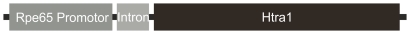
Scheme of the transgenic construct Rpe65/Htra1 (3123 bp).